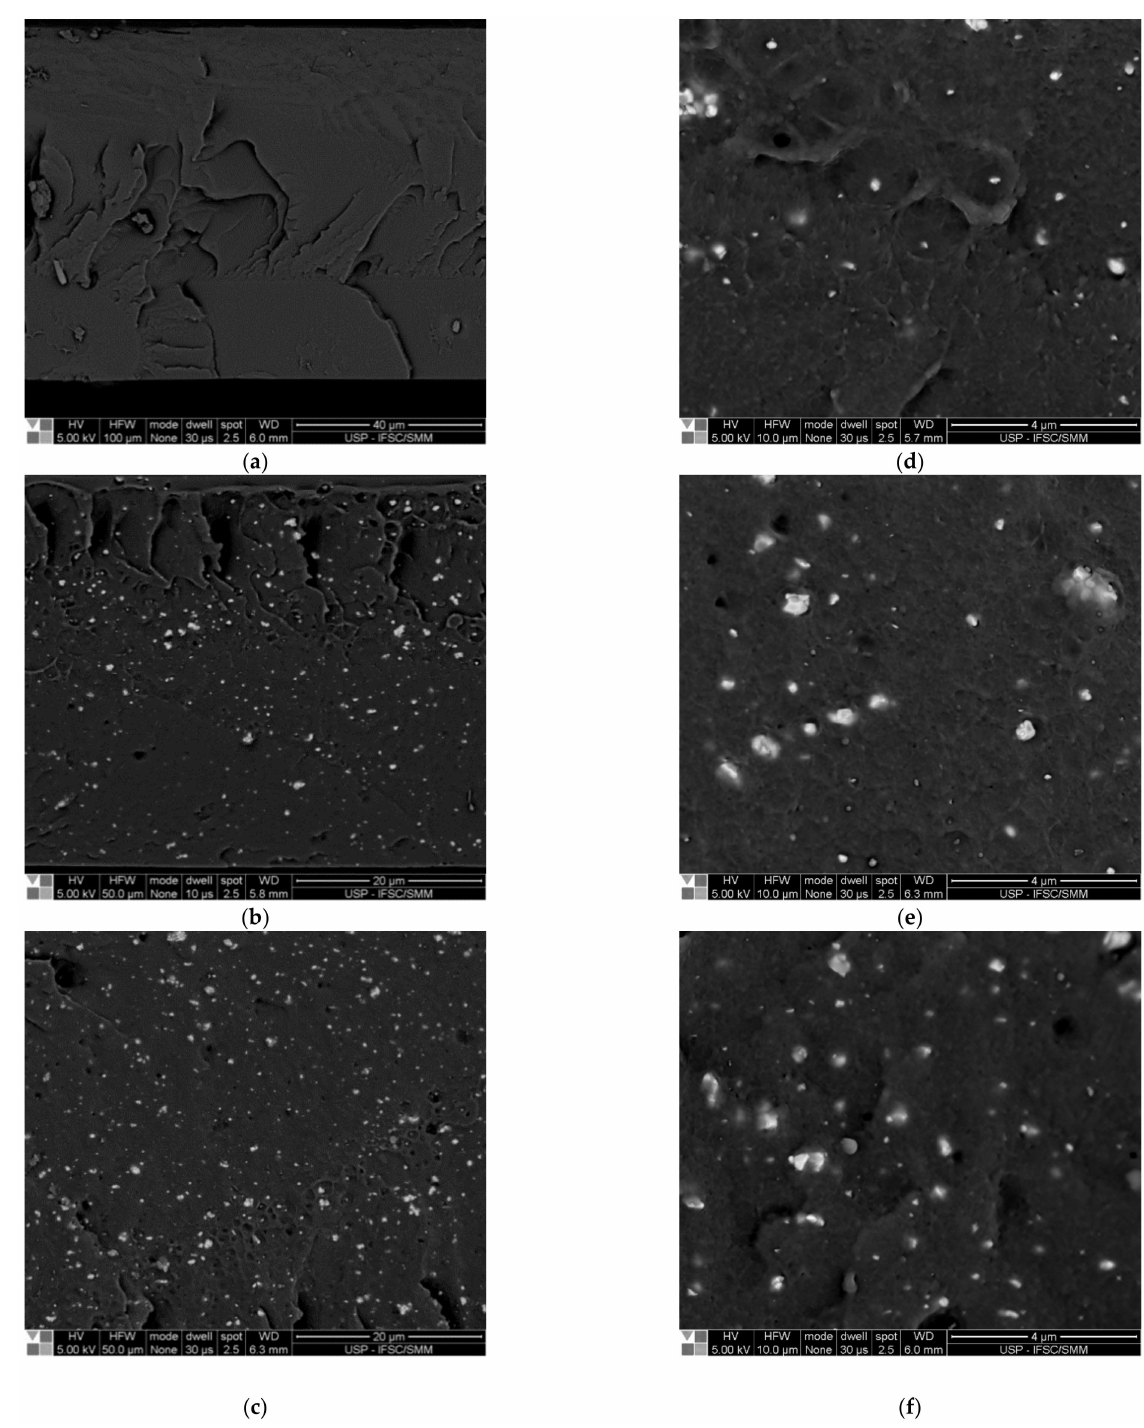
Figure 7. SEM images of fractured surfaces of films: ( a ) SNa0; ( b , d ) SNaPZT3; ( c , e ) SNaPZT5; and ( f )